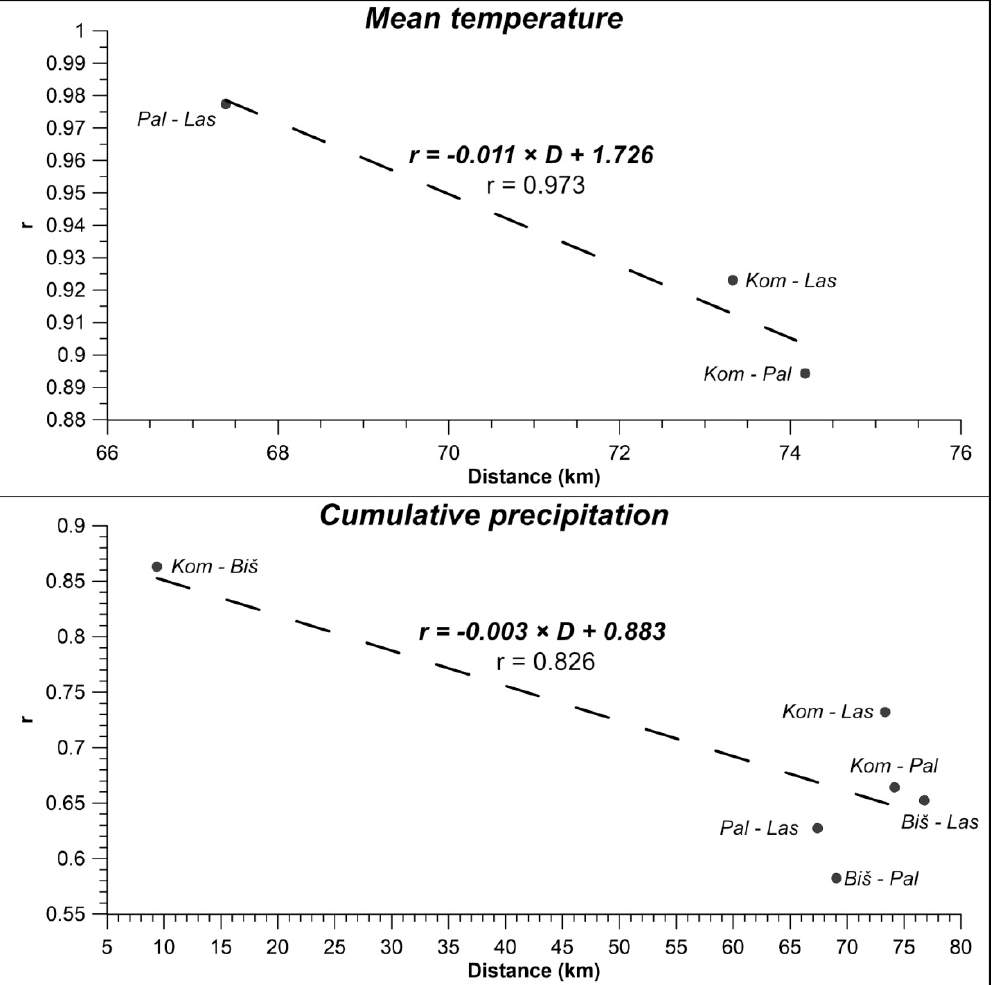
Figure 9. The ratio of the linear correlation coefficient r of the mean annual air temperature (up) and precipitation (down) against the distance between stations, L.